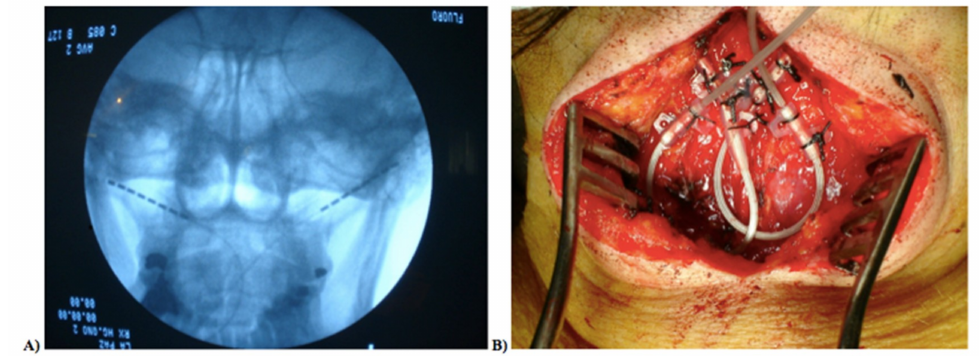
Figure 1. ( A ) Anteroposterior X-ray electrode image, after removing the needles, prepared for stimulation; ( B ) fascia anchor in suboccipital